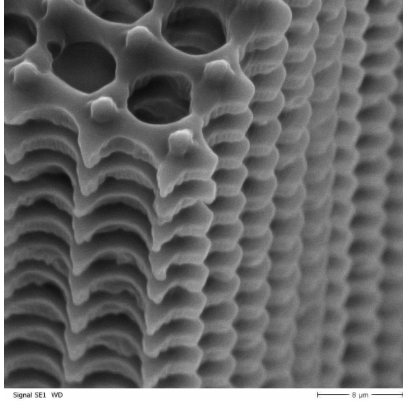
Figure 13. Structure with 35x35x35 micro cells, Detail